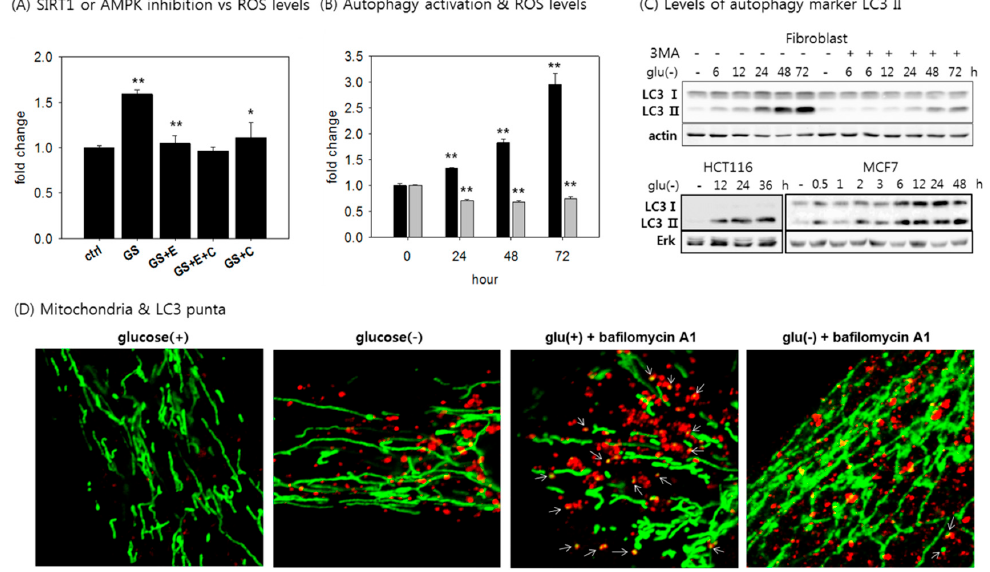
Figure 5. Activation of autophagy and the attenuation of mitophagy in glucose-deprived cells. ( A ) Cells were glucose deprived for three days in the presence or absence of 10 µ M EX527 (GS + E) or 2 µ M compound C (GS + C), or both (GS + E + C), stained with mitoSOX, and subjected to flow cytometric analysis; ( B ) cells were incubated in glucose-free medium (black bar), or treated with 250 nM torin1 (grey bar) for the indicated time period. Mitochondrial superoxide was stained with mitoSOX and detected by flow cytometry; ( C ) fibroblast, HCT116, or MCF7 cells were glucose-deprived in the presence or absence of 5 mM 3-MA for the indicated time points, and subjected to immunoblotting for LC3 protein; ( D ) cells were glucose-deprived for 12 h and treated with 200 nM bafilomycin A1 for 12 h, which has been shown to block mitophagy [52]. After fixing, mitochondria (green) and autophagosomes (red) were visualized with confocal microscopy using mouse anti-OXPHOS antibody and rabbit anti-LC3 antibody, respectively. All flow cytometry was carried out in, at least two biological repeats. All scale bars in microscopy indicate 5 µ m. Values are presented as mean ± s.d.; * p < 0.05, ** p < 0.01 by